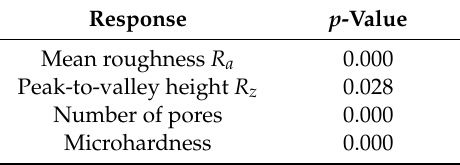
Table 7. Results for the ANOVA to test the significance of VED in the range 60–480 J · mm − 3